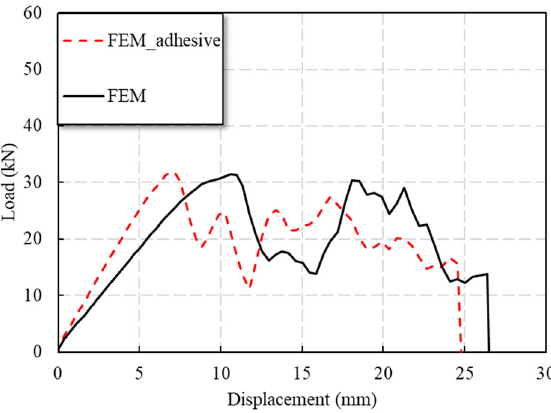
Figure 15. Comparison of FE model results: bolted and bolted–bonded hybrid connection.